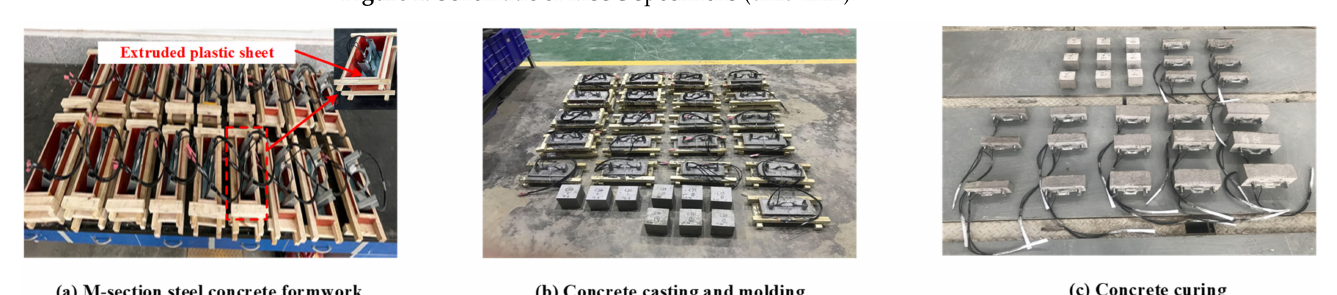
Figure 3. Preparation process of MSSC